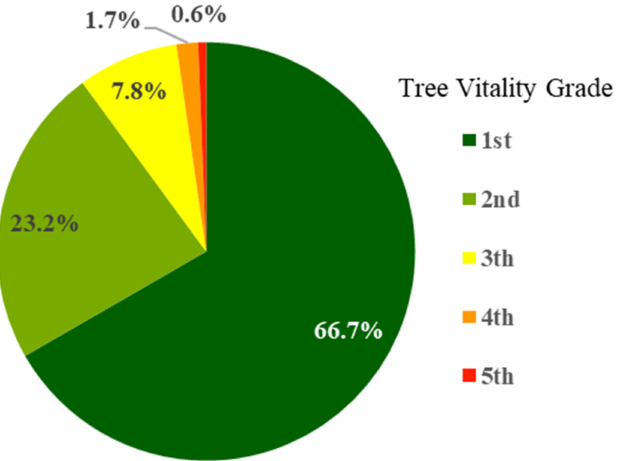
Figure 2. Distribution ratio of trees surveyed based on